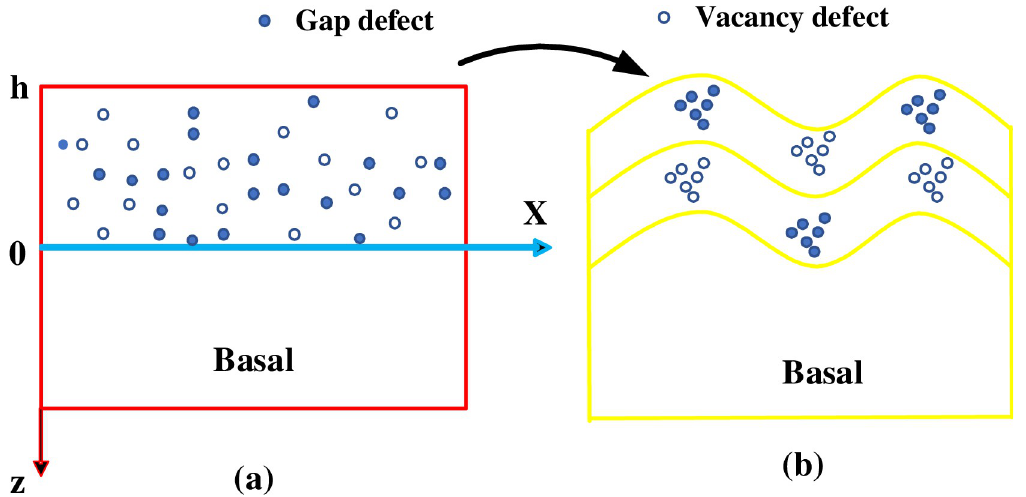
Fig 1. State model diagram of black silicon (a. initial state; b. model diagram after multi-pulse action).